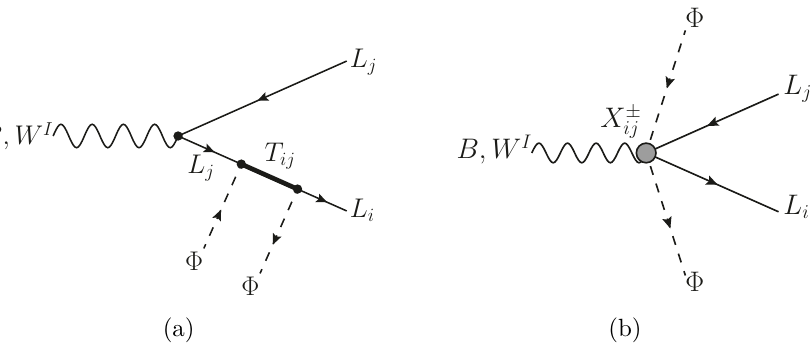
Figure 3. (a) Diagram giving rise to modifications of the lepton couplings to the U(1) Y and SU(2) L gauge bosons in the type-I seesaw. (b) Corresponding diagram in the effective